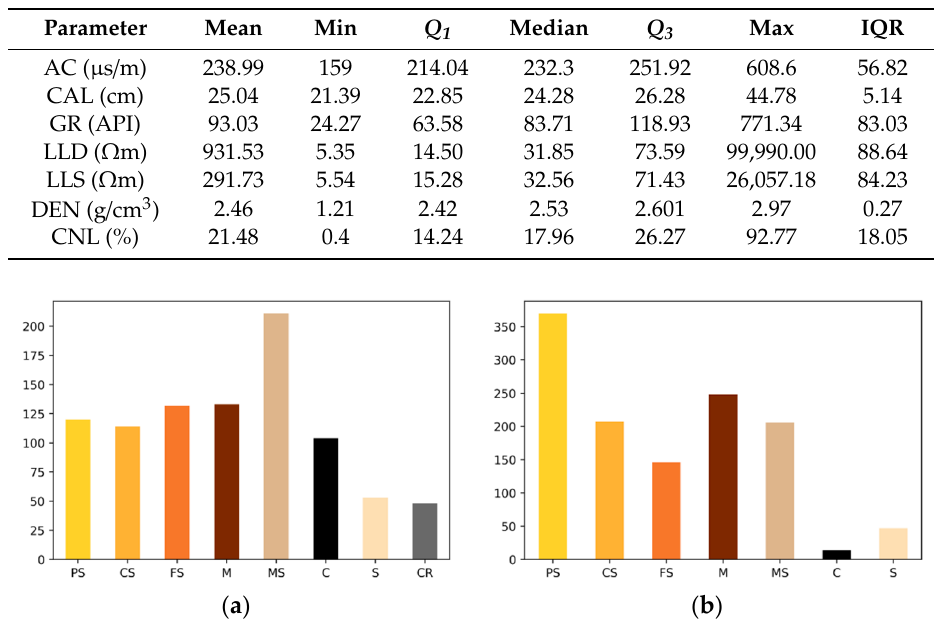
Figure 2. The number of samples in each class for the research areas: ( a ) The distribution of lithologies in the Daniudi gas field (DGF); ( b ) the distribution of lithologies in the Hangjinqi gas field (HGF).